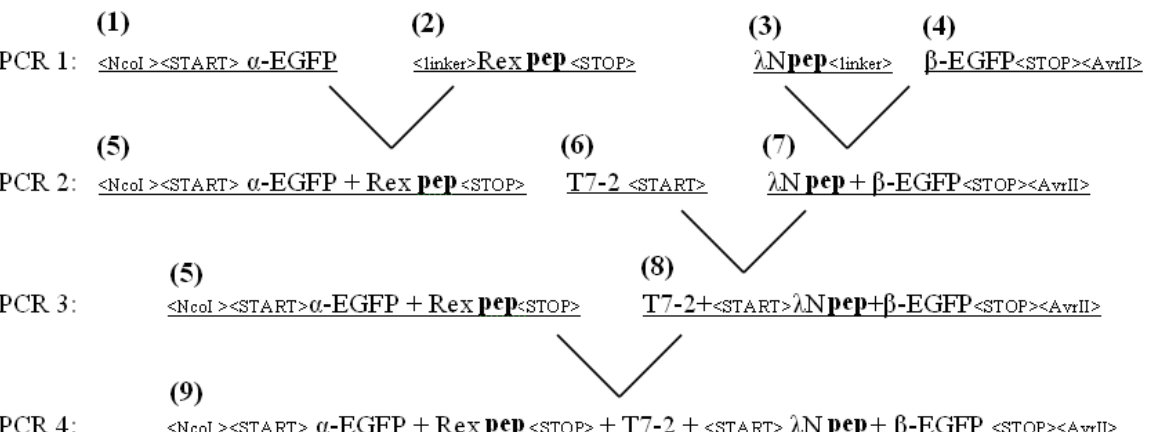
Figure 2s. Multi-step PCR used to obtain DNA fragment encoding the two fusion proteins and all regulatory regions Each pair of PCR products to be joined has about 10 bp of sequence overlap. Pairs were mixed and used as a template for the next PCR reaction. The plasmid containing EGFP gene (from Clonetech) was used as a template for PCR products (1) and (4). Templates for PCR products (2), (3) and (6) were custom synthesized. After PCR 1, PCR products (1) and (2) were mixed and used as a template for amplifying PCR product (5). PCR products (3) and (4) were mixed and used as a template for amplifying PCR product (7). After PCR 2 amplification, PCR products (6) and (7) were mixed as a template for amplifying PCR product (8). The last PCR 4 was carried out by mixing PCR products (5) and (8) as a template. Final PCR product (9) was inserted into pACYCDuet-1 vector. Sequences of DNA templates and primers are listed in Table 1s and Table 2s.